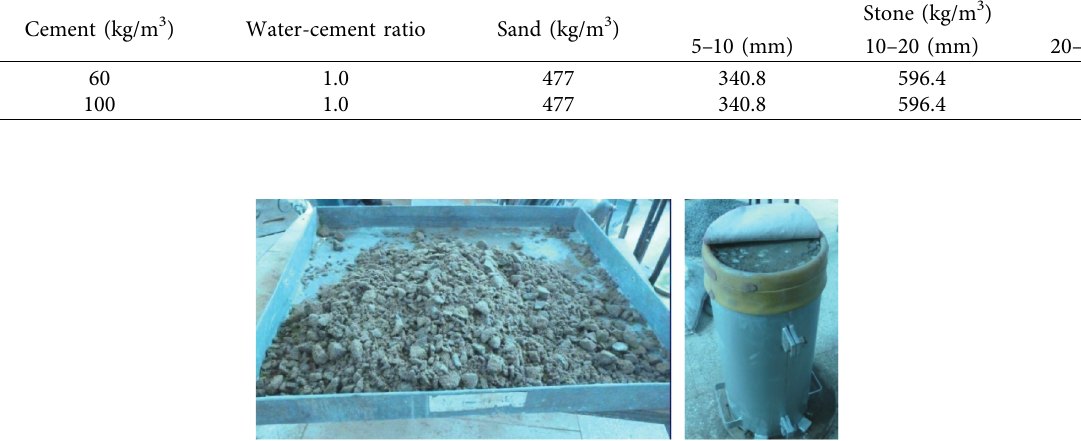
Figure 1: The specimen of LCSG material for the triaxial test.